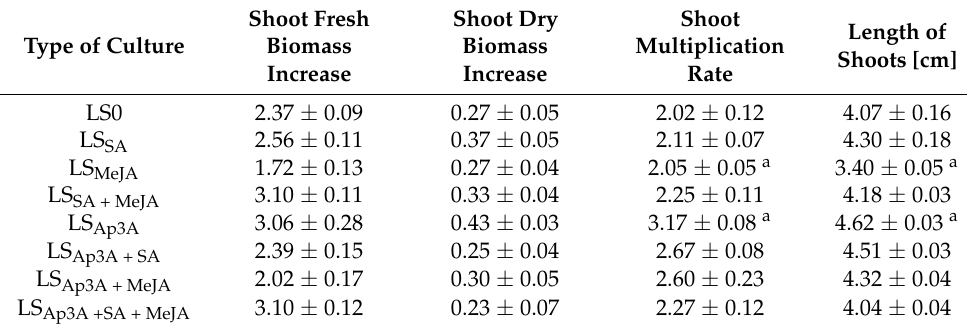
Table 1. The effect of culture conditions on the growth of Polyscias filicifolia shoots of cultivated in vitro under various culture